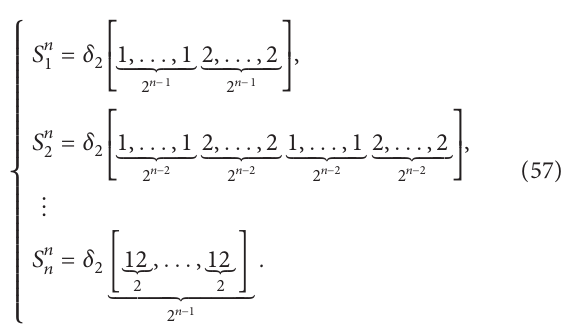
Algorithm 3 Consider the graph given in Corollary 3.